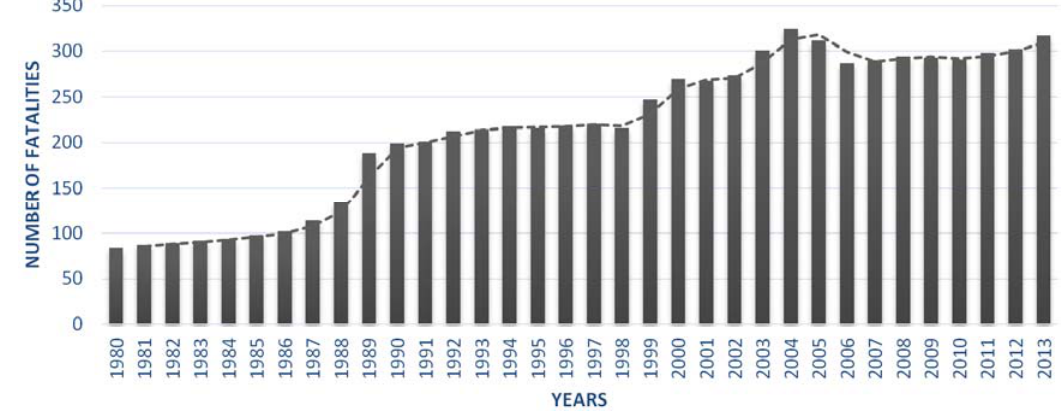
Fig. 1. Number of road accident fatalities in South